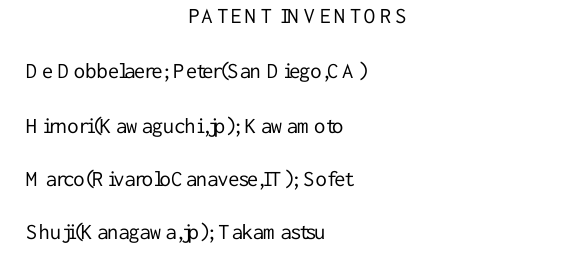
Table 4. Database after applying database